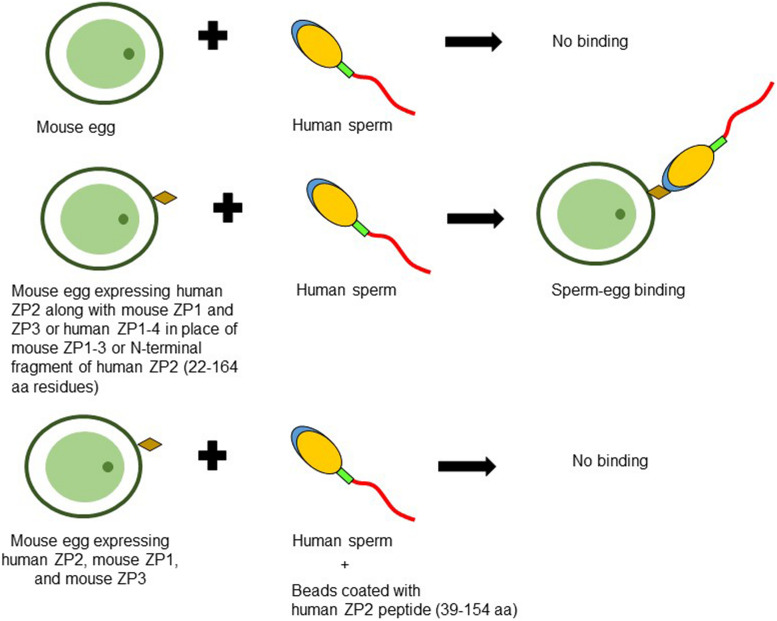
Schematic diagram to illustrate binding of human sperm to transgenic mouse oocyte expressing human ZP2. No binding of human capacitated sperm is observed when incubated with mouse eggs expressing mouse ZP1, ZP2, and ZP3. However, zonae from transgenic mouse lines expressing either human ZP2, mouse ZP1, and mouse ZP3 or human ZP1-4 in place of mouse ZP1-3 or those expressing human ZP2 N-terminal fragment corresponding to 22–164 aa residues instead of mouse ZP2, showed binding with human sperm suggesting its important role in human sperm-egg binding. Agarose beads coated with human ZP2 peptide (39–154 aa residues) inhibited the binding of human sperm to transgenic mouse oocytes expressing human ZP2 (Baibakov et al., 2012; Avella et al., 2014, 2016).